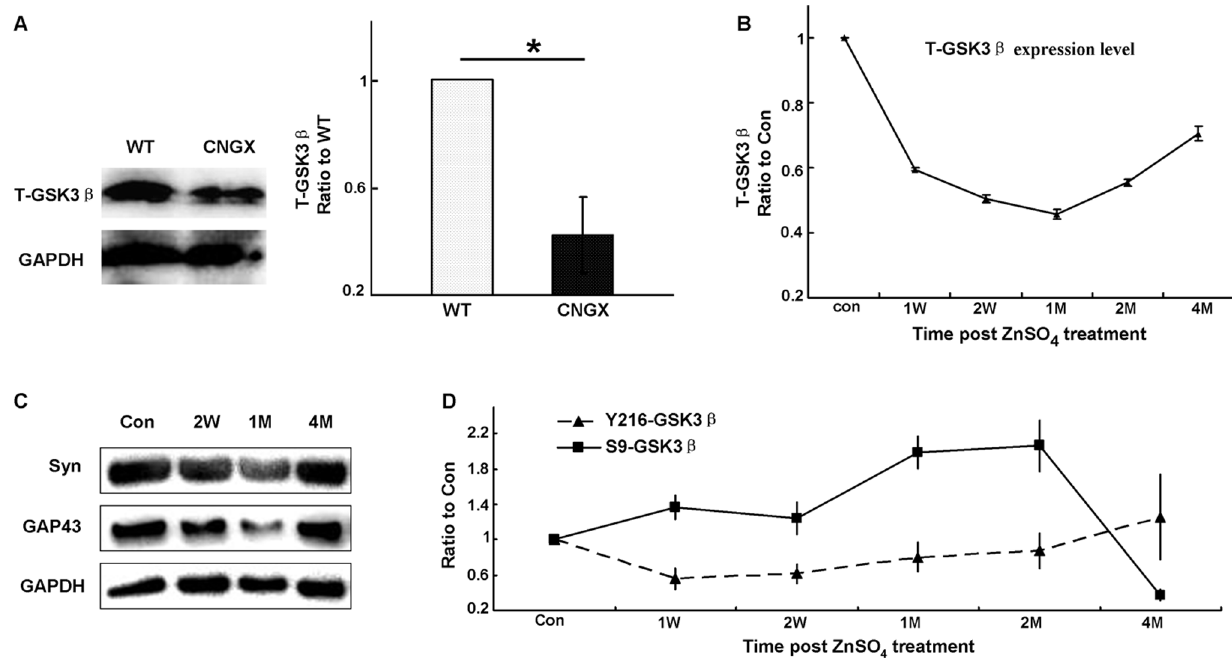
Figure 2. Western blot analysis of GSK3 b expression level and activity in the OBs of olfactory-defective mice. A: Western blot revealed that the T-GSK3 b expression level was significantly decreased in OBs from CNGX mice (n=6, P , 0.05). B: The T-GSK3 b expression level changed dynamically during the ZnSO 4 irrigation and recovery stages (ratio to control, n=5–6). C: Western blot revealed that Syn and GAP43 were reduced in the OB at 2 weeks and 1 month post-irrigation, and then increased 4 months post-ZnSO 4 irrigation. D: The expression patterns of Y216-GSK3 b (ratio to control, n=5–6 mice) and S9-GSK3 b (ratio to control, n=5–6) in the OB following ZnSO 4 irrigation. Syn, synaptophysin; GAP43, growth associated protein 43. * P , 0.05. The data shown are the average 6